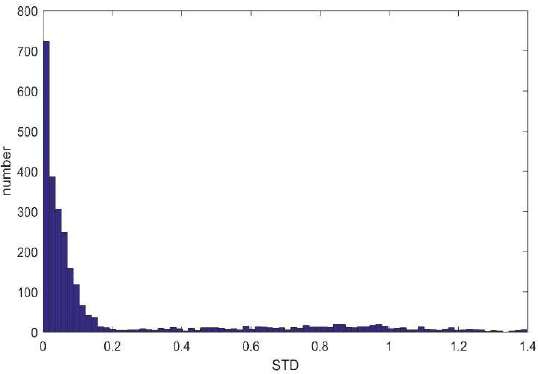
Figure 15. The frequency histogram of differences (standard deviations) between TCCON XCO 2 (14 sites) and the corresponding averaged XCO 2 in 2010 at 2° × 2.5° grids.